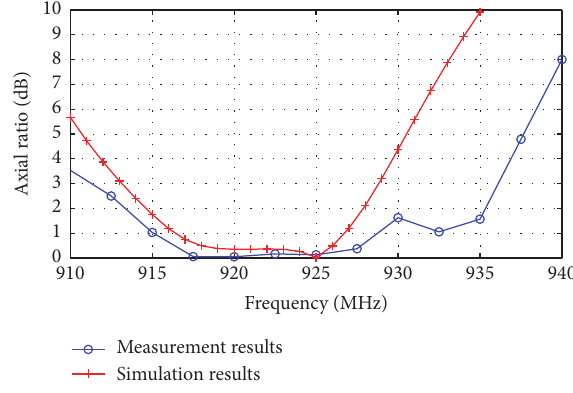
Figure 6: 𝑆 11 of the 4 × 4 SR antenna array.